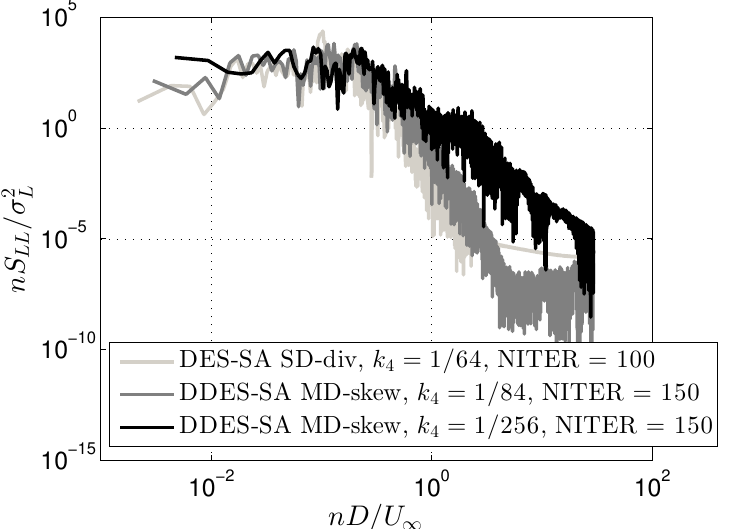
Figure 10. Comparison of lift power spectral densities obtained with three different DES computations for the rectangular 5:1 cylinder (see Table 2).